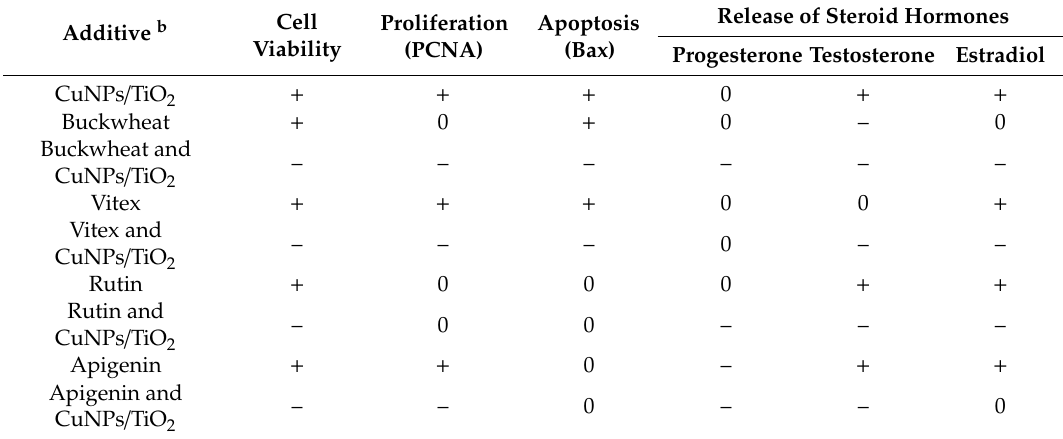
Table 1. Character of the e ff ect of CuNPs / TiO 2 , buckwheat, vitex, rutin, and apigenin, given alone, on cultured porcine ovarian granulosa cell functions, and the ability of buckwheat, vitex, rutin, and apigenin to modify the activity of CuNPs / TiO 2 a